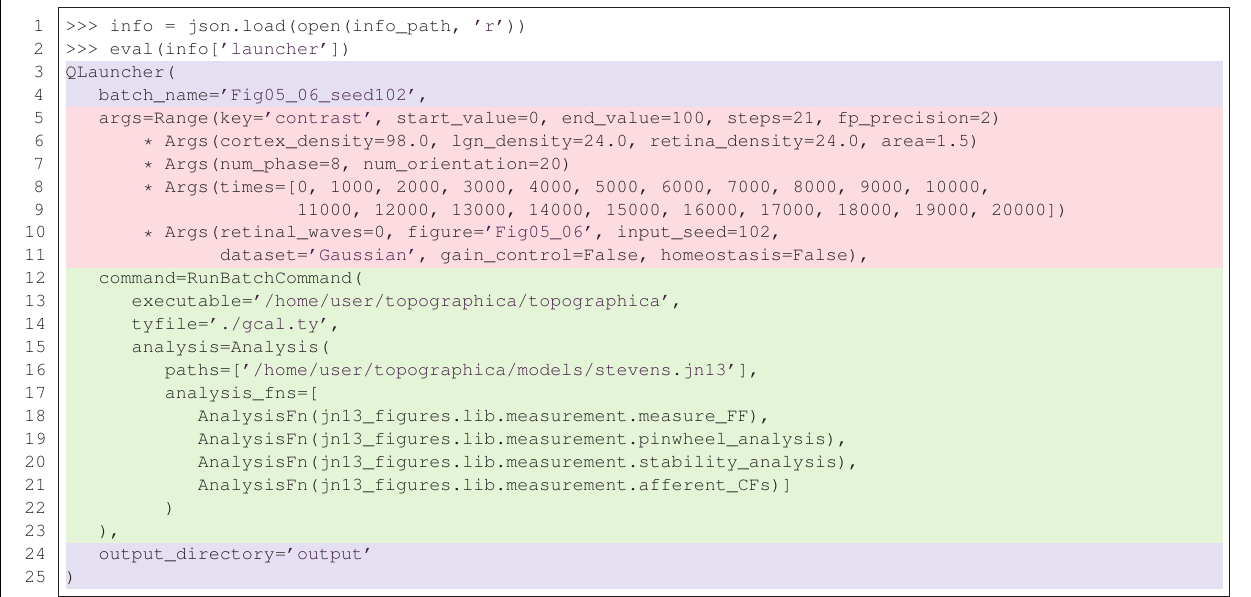
simulations used to generate Figures 5 and 6 from Stevens et al. (2013). Using a version control system also allows the state of the executed code (simulator, analysis, measurement code etc) to be restored based on the information stored in the .info